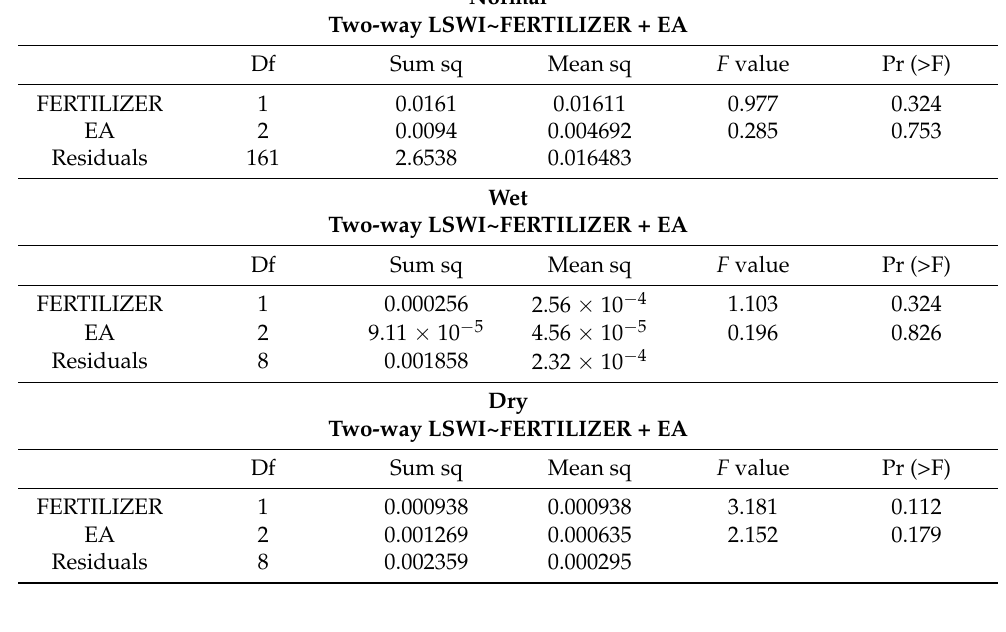
Table 5. Interaction ANOVA results for fertilizer (broiler litter or inorganic) and endophyte associa- tions (EA; free, novel, or